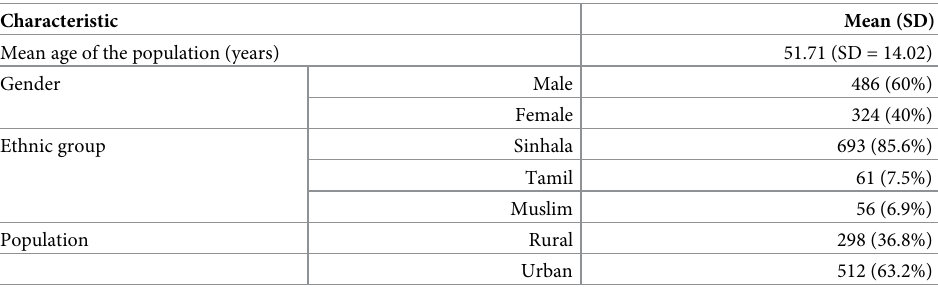
Table 1. Basic sociodemographic